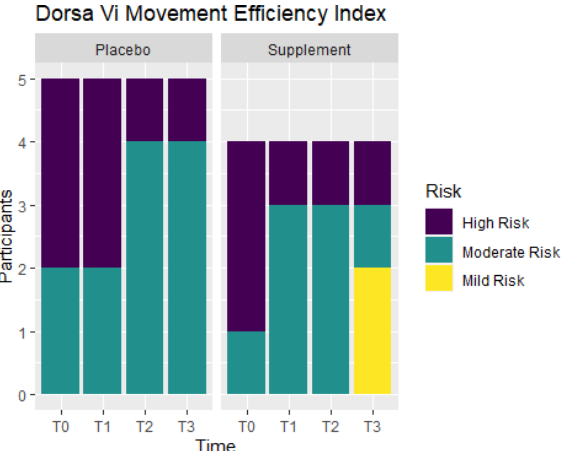
Figure 11. Movement Efficiency Changes Over Time. DorsaVi Movement Efficiency in the Supplement and Placebo Groups were recorded to compare results at points T0, T1, T2 and T3. Results show the majority of the participants improved by T3. High Risk participants are in purple, Moderate Risk in green, and Mild Risk in yellow.